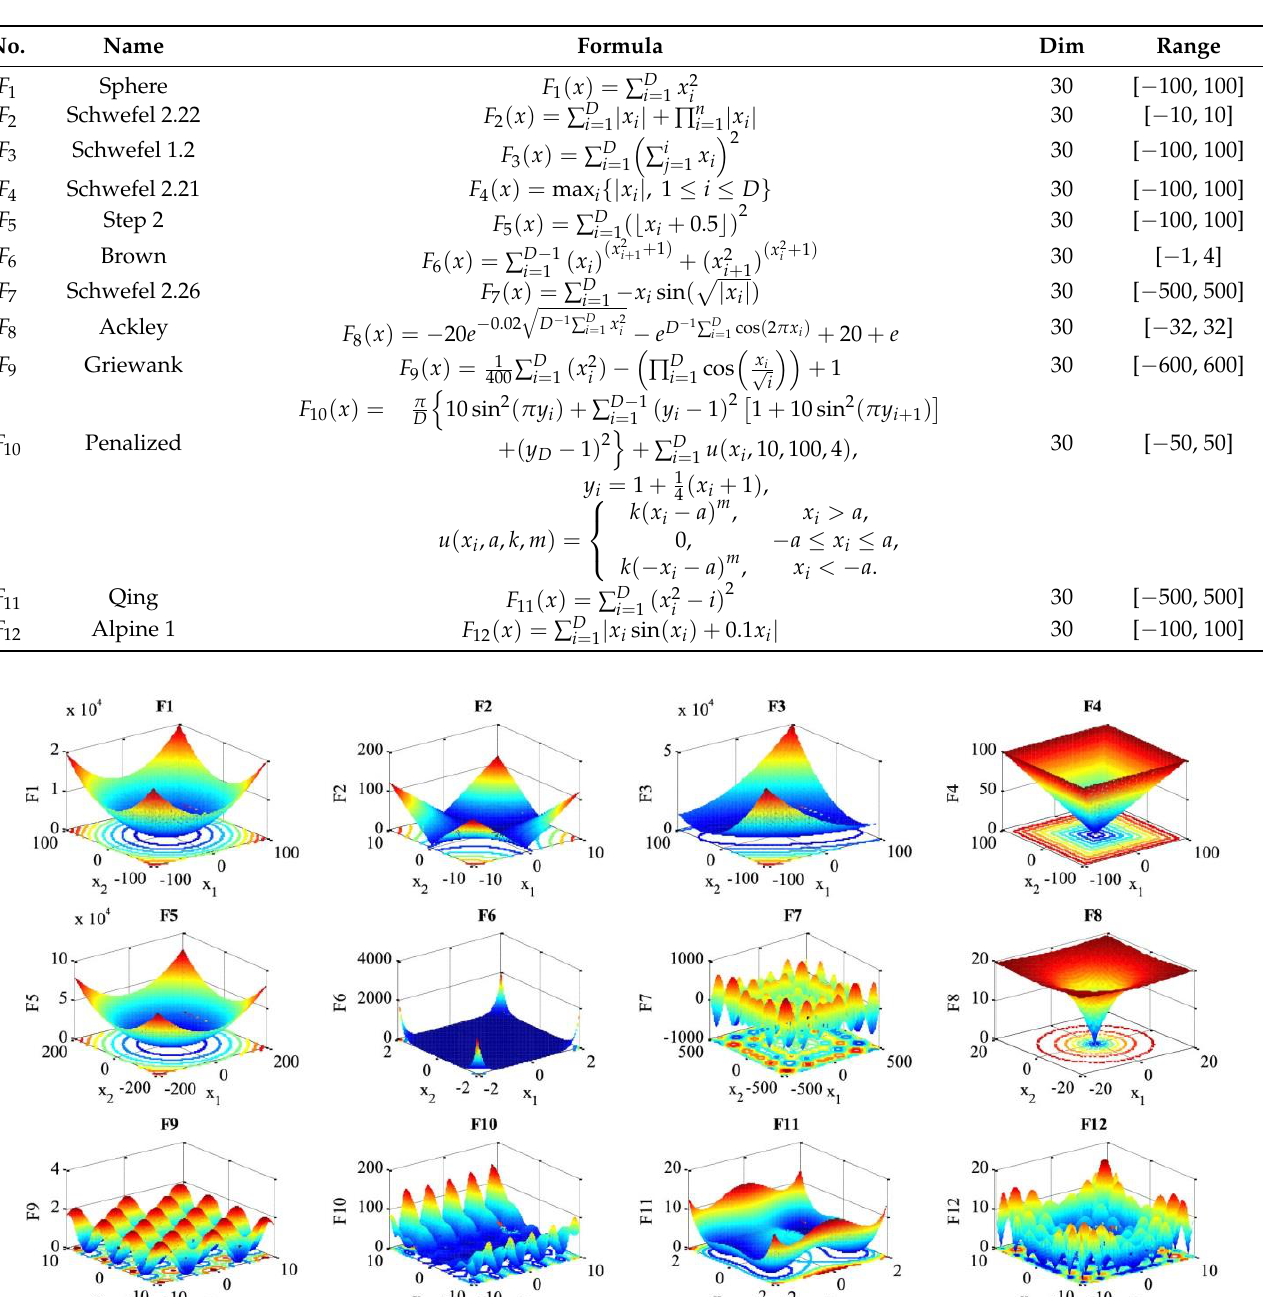
Table 1. Mathematical benchmark functions.